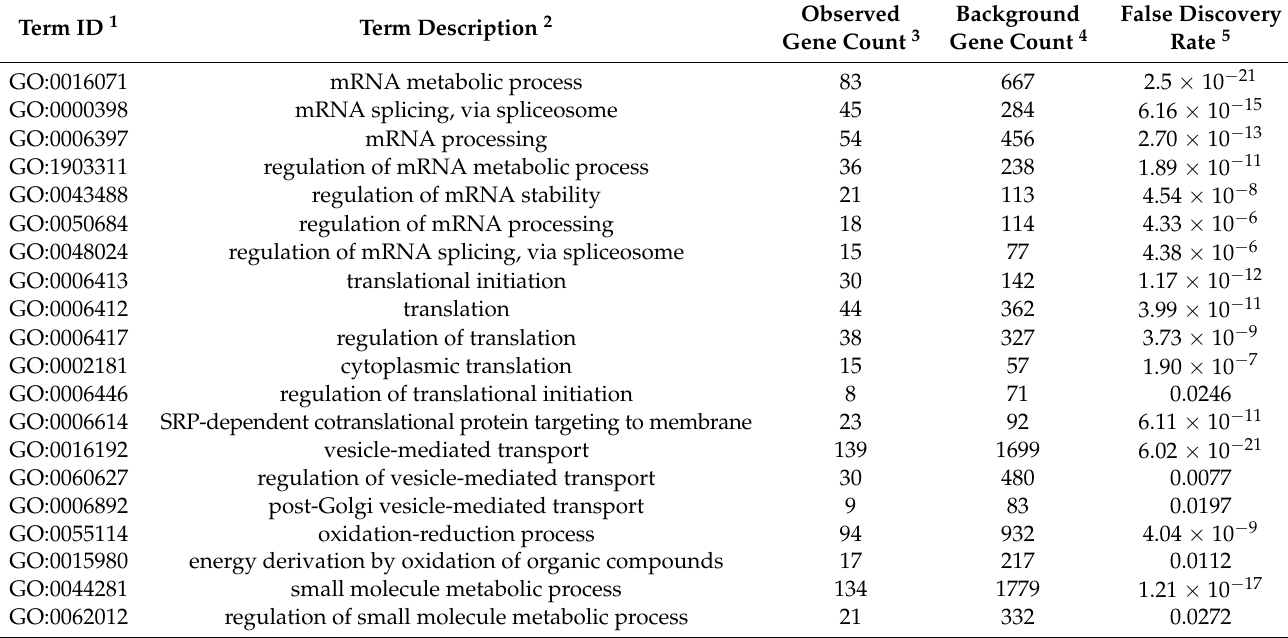
Table 1. Selected biological processes altered in HF-MSS, based on Gene Ontology enrichment analysis. Term ID